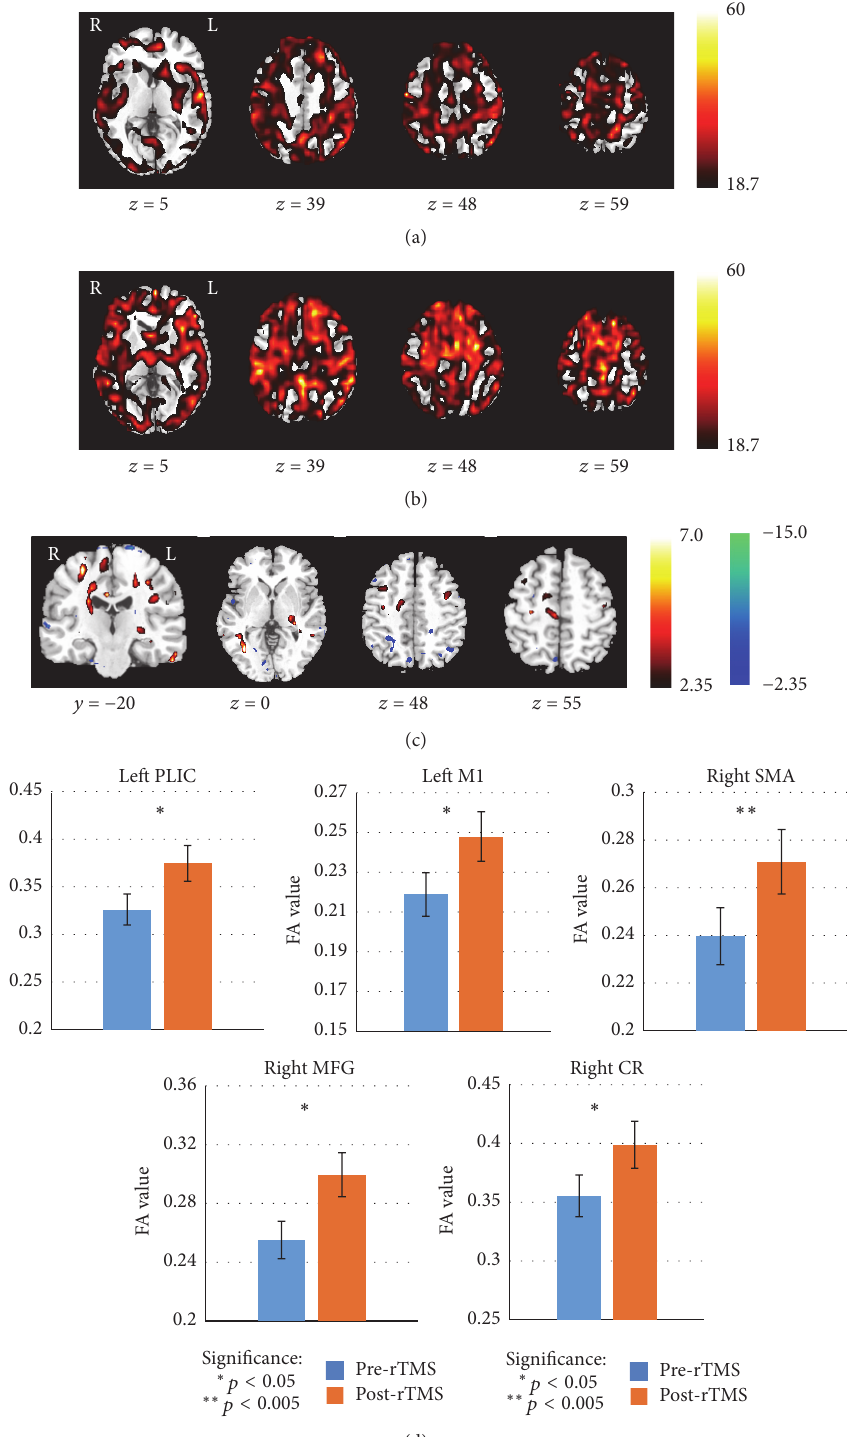
Figure 2: Comparison of FA maps between pre- and post-rTMS treatment for stroke patients in RT group. The FA results of one-sample 𝑡 -test for stroke patients of pre- (a) and post-rTMS treatment (b). (c) Significantly changed brain areas are superimposed on the che2bet hemisphere of the Montreal Neurological Institute template brain in the three-view drawing ( 𝑝 < 0.05 ). The warm and cold tones separately indicate the increased and decreased FA value after rTMS treatment. (d) Bars represent the mean FA values. Vertical bars indicate estimated standard errors. Compared with the pre-rTMS treatment, the mean FA showed a significant increase after rTMS treatment in bilateral posterior limb of internal capsule (PLIC), left precentral gyrus (PG), right supplementary motor area (SMA), right middle frontal gyrus (MFG), and right corona radiate